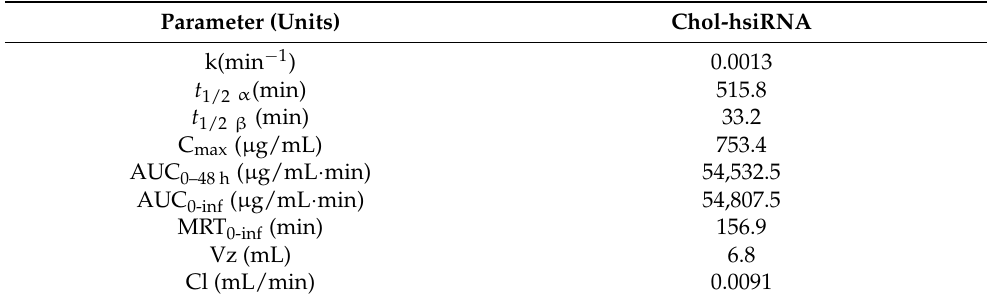
Table 2. Pharmacokinetic parameter of Chol-hsiRNA after intravenous injection adapted by Godinho et